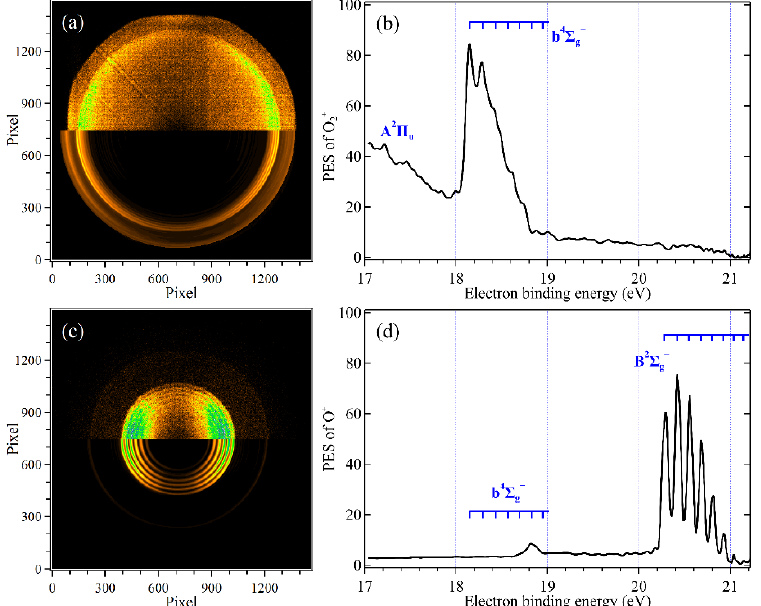
Figure 3. Mass-selected electron images and their corresponding photoelectron spectra, ( a , b ) the O 2+ parent ion, ( c , d ) the O + fragment ion.